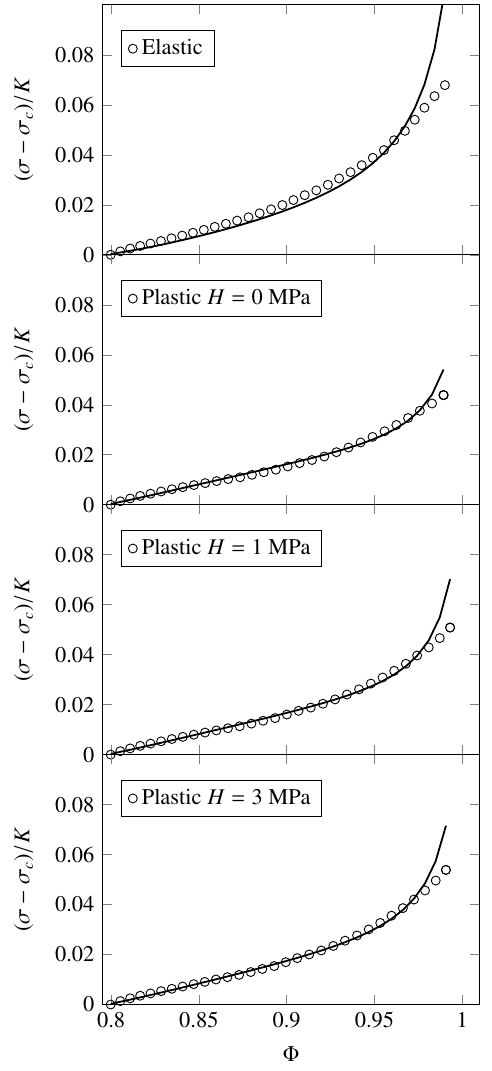
 Figure 4. The excess applied stress  c normalized by the  grain bulk modulus K as a function of packing fraction  for elastic and elasto-plastic grains.  c corresponds to the jamming point,  c 0 . 8. The lines show the predicted behaviors beyond ' jamming state by the compaction models introduced in this pa- per; see Eqs. (8) and